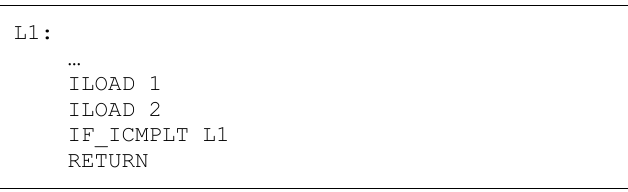
Fig. 7. Second branching example.